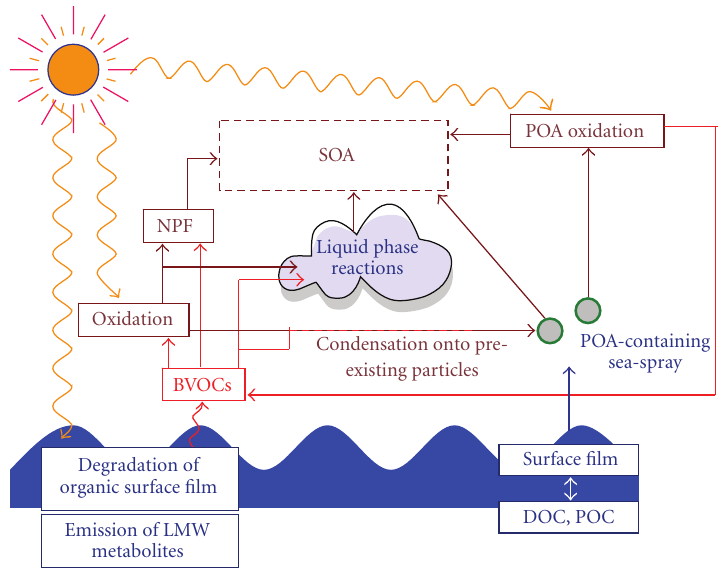
Figure 1: Diagram summarizing primary and secondary organic aerosol main formation routes in the marine boundary layer. DOC, POC and POA stand for Dissolved Organic Carbon, Particulate Organic Carbon and Primary Organic Aerosol, respectively